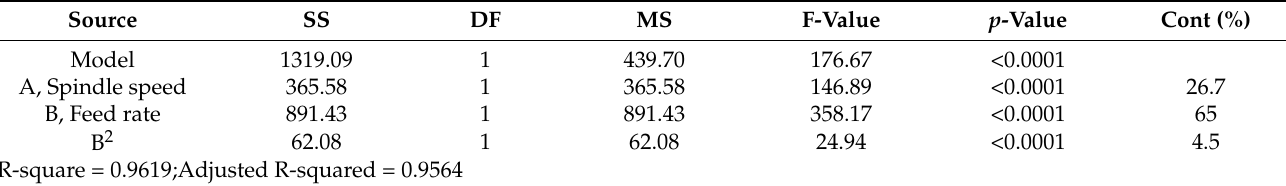
Table 6. ANOVA results for